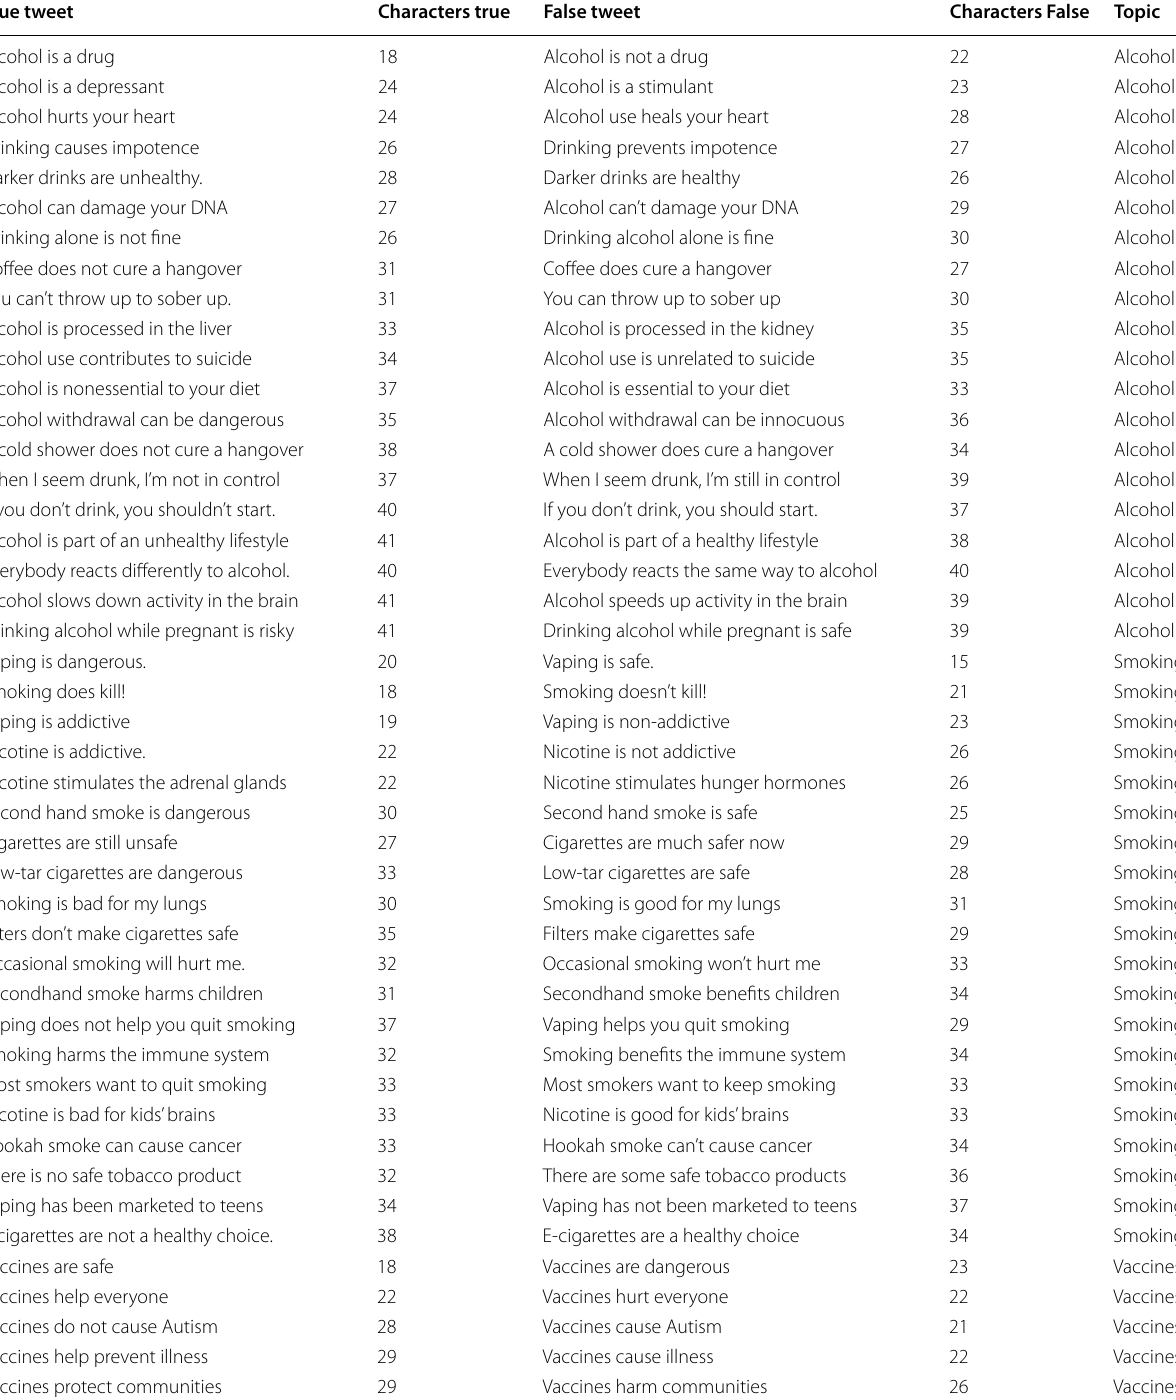
Table 3 Text of statements and tweets used in Experiments 1 and